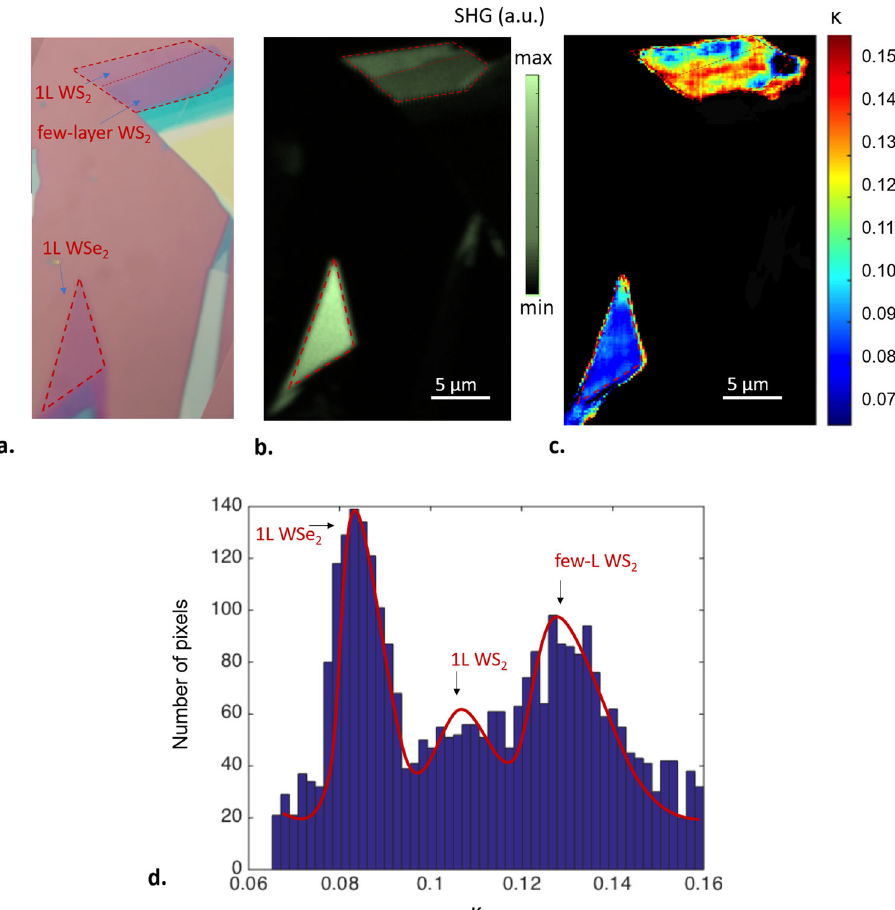
Fig. 6 Comparison of valley population imbalance between atomically thin WS 2 and WSe 2 . a Optical image of a large area comprising monolayer and few-layer WS 2 as well as monolayer WSe 2 . The corresponding areas are encircled by the red dashed lines. b SHG intensity imaging at 78 K. c VPI imaging and d histogram in terms of the dimensionless parameter κ at 78 Κ